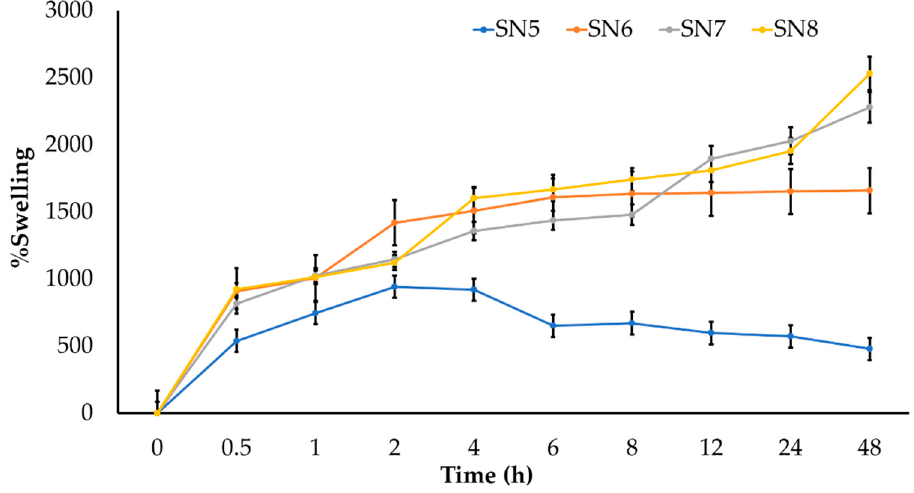
Figure 8. Swelling studies of hydrogels (SN5-SN8) in PBS pH 7.4.